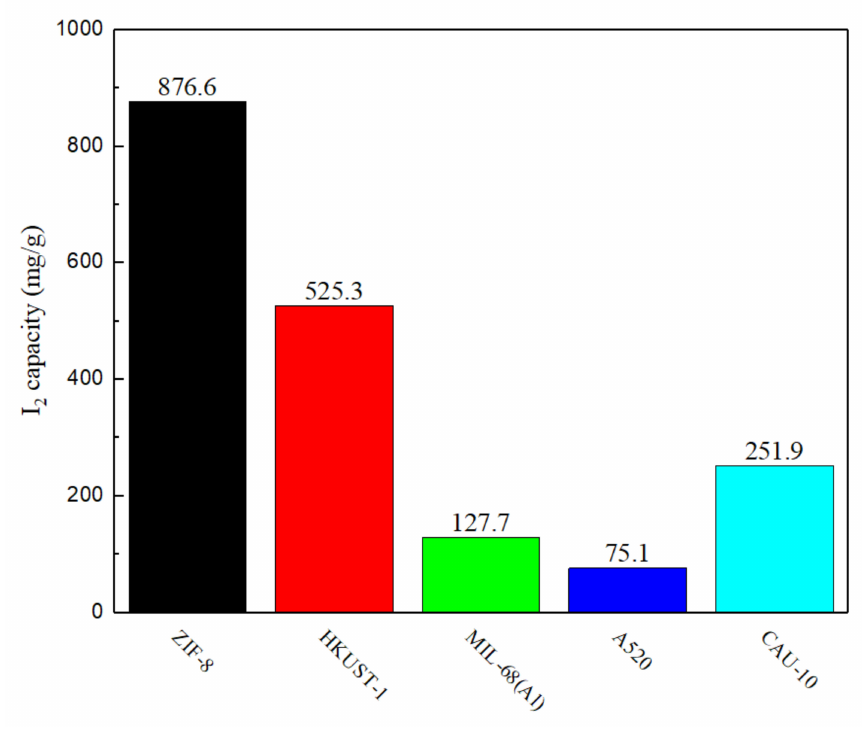
Figure 2. MOF captures I 2 adsorption results.